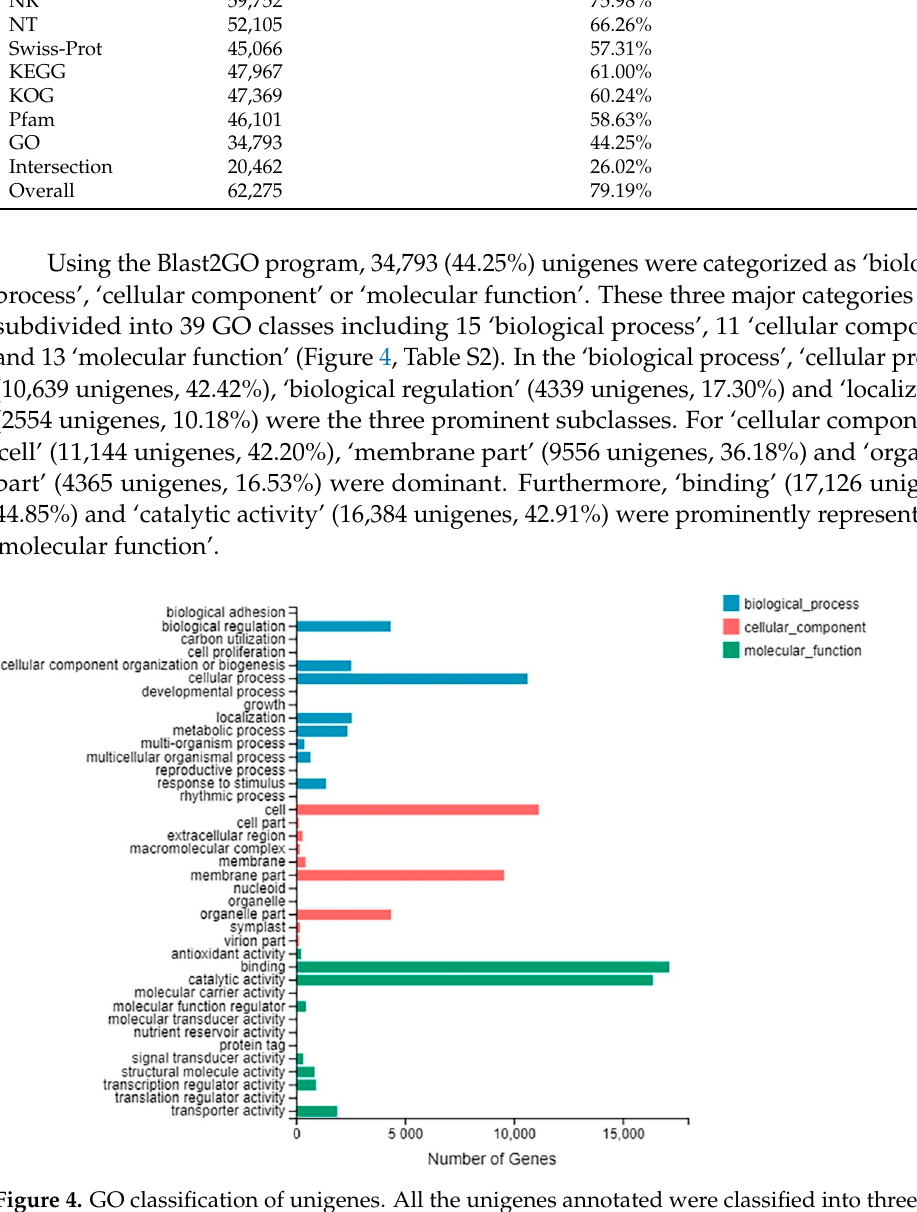
Figure 4. GO classification of unigenes. All the unigenes annotated were classified into three main categories: biological process, cellular component and molecular function.